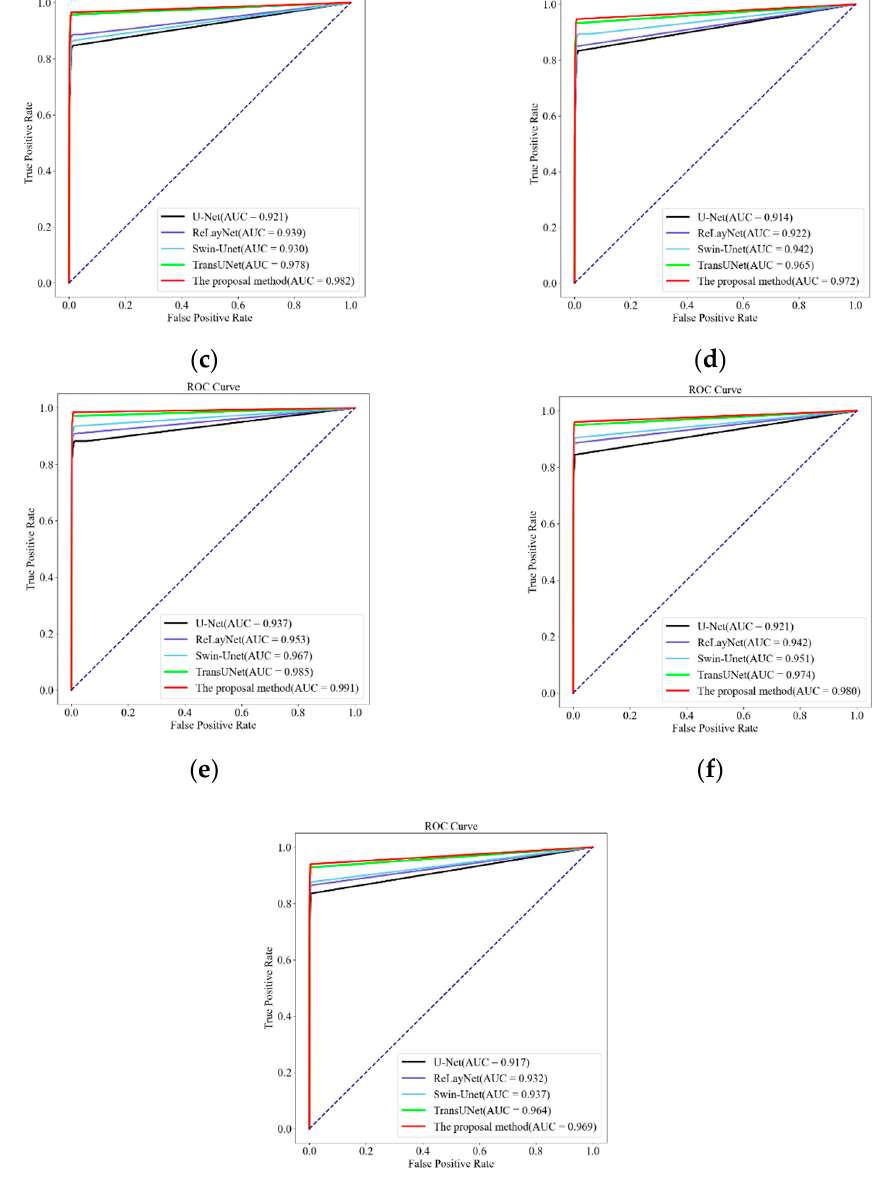
Figure 7. Comparison of ROC curves of the segmentation results of the proposed method and other methods at each layer: ( a ) NFL layer; ( b ) GCL-IPL layer; ( c ) INL layer; ( d ) OPL layer; ( e ) ONL-ISM layer; ( f ) ISE layer; ( g ) OS-RPE